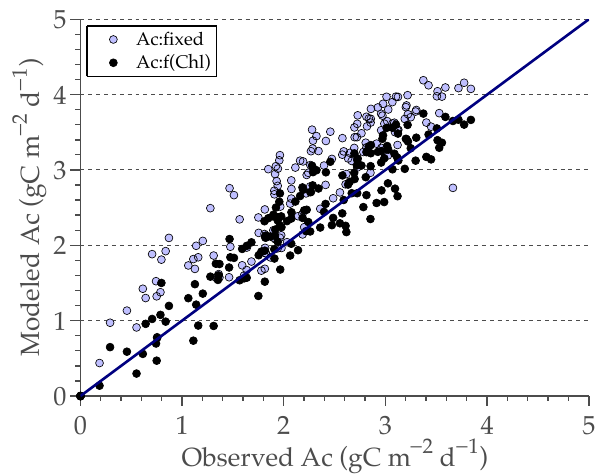
807 Fig. 10. Comparison of hourly modeled and measured canopy carbon assimilation fluxes for 808 Figure 10. Comparison of hourly modeled and measured canopy maize and soybean at Mead, NE, generated with TSEB-LUE using fixed values of 𝛽 ! (hollow 809 carbon assimilation fluxes for maize and soybean at Mead, NE, gen- points) and 𝛽 ! as a function of Chl (solid points). 810 erated with TSEB-LUE using fixed values of β n (light-blue points) and β n as a function of Chl (black